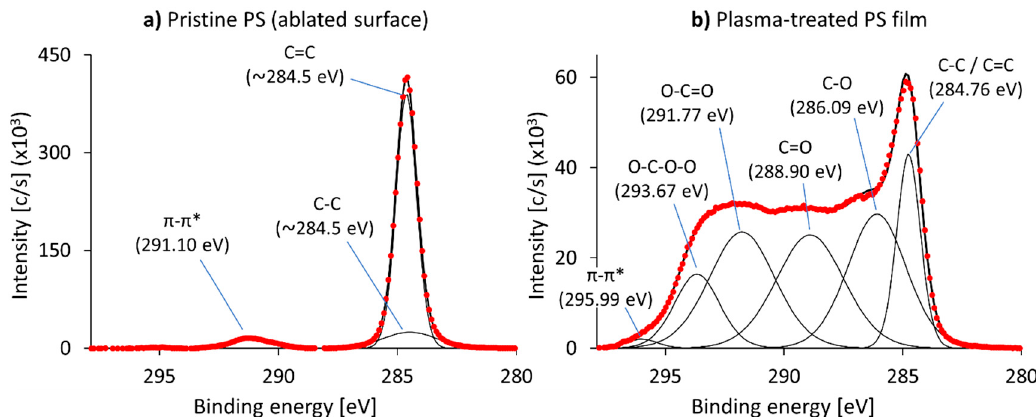
Figure 3. Background corrected C1s spectra of ( a ) pristine (after Ar cluster surface ablation) and ( b ) plasma-treated ABS. The measured spectrum is depicted as points, whereas the envelope and the deconvolution thereof are depicted as solid lines. (Please note that the scale of the vertical axes is different in the two graphs as we wanted to compare the C=C peaks. This way, the areas of the two C1s spectra are visually comparable, too).